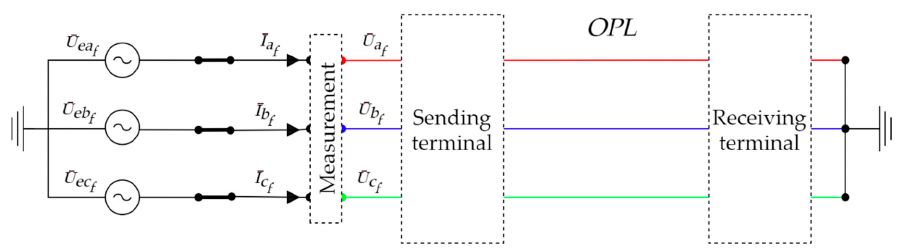
Figure 2. M1—Three-phase symmetrical measurement of positive sequence impedance.